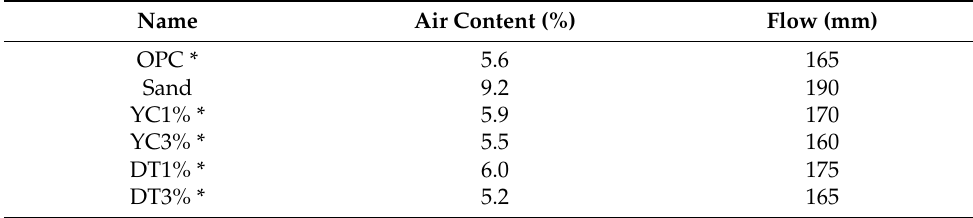
Table 5. Air content and flow of the specimens.